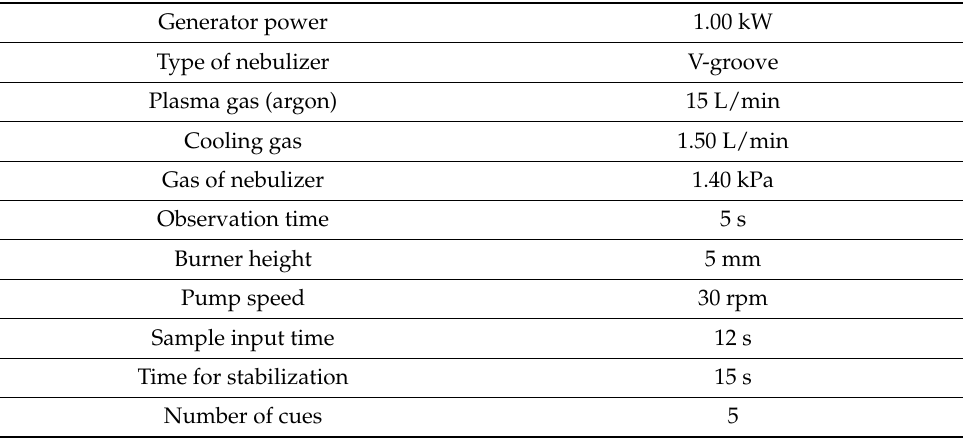
Table 1. Optimized instrumental parameters for ICP-OES measurements.